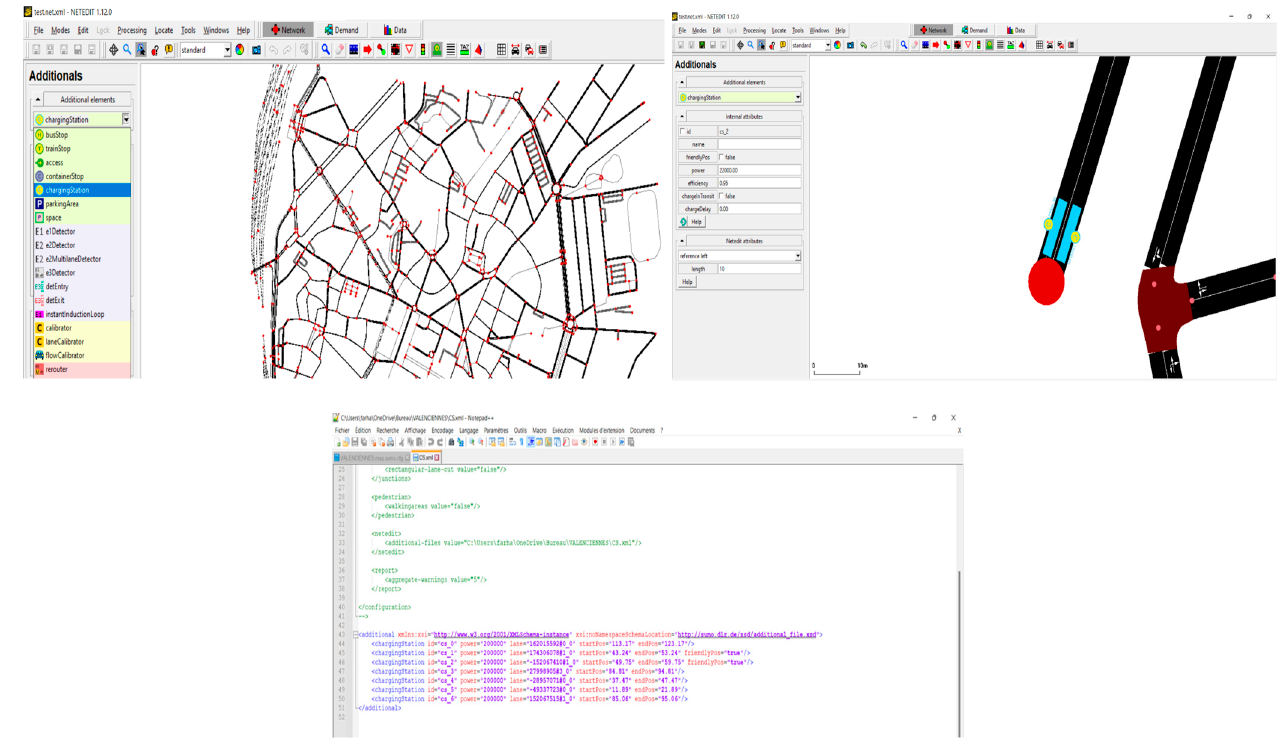
Figure 6. insertion of CS in the map.